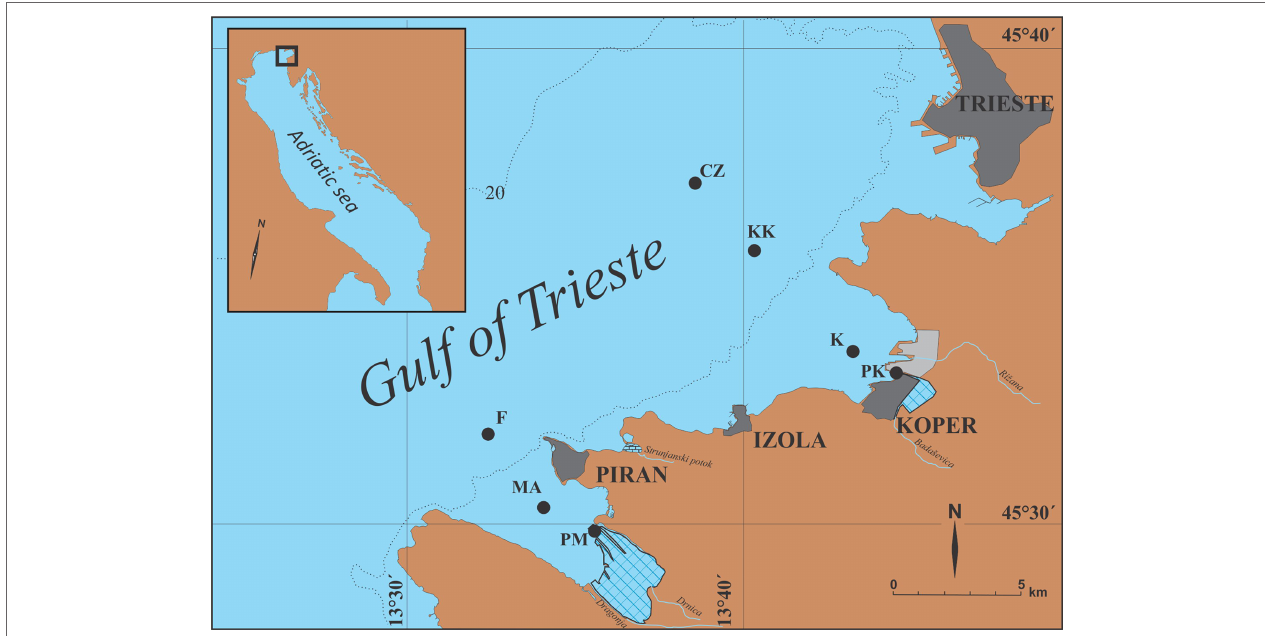
FIGURE 1 | Location of sampling sites in the study